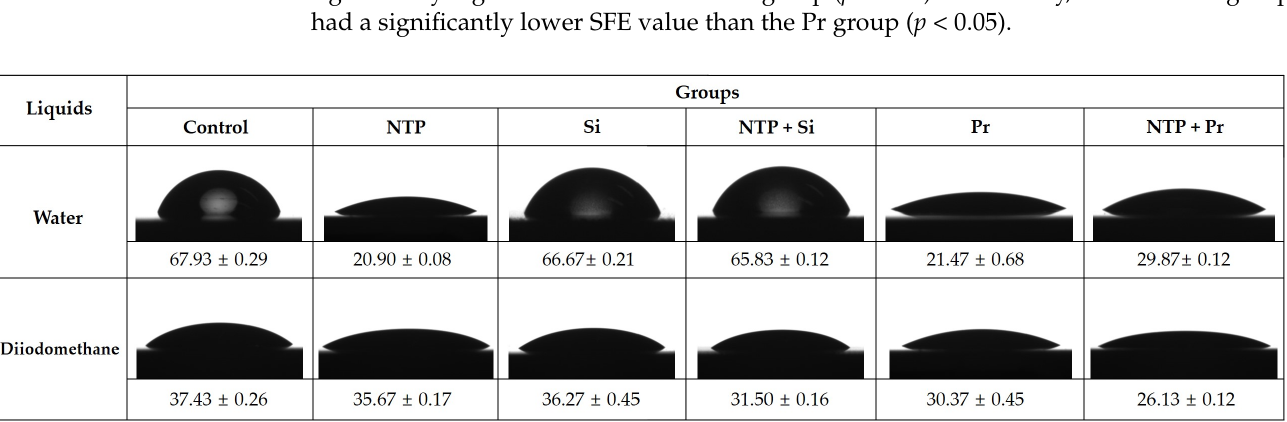
Figure 6. Contact angle images and values of water and diiodomethane droplets on zirconia surfaces. Control, no treatment. NTP, non-thermal atmospheric pressure plasma. Si, Silane. NTP + Si, NTP followed by Silane. Pr, Z-Prime Plus. NTP + Pr, NTP followed by Z-Prime Plus.